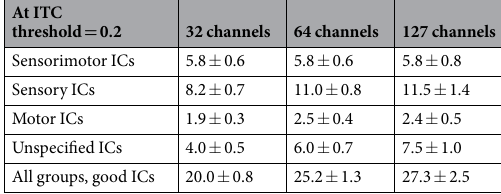
Table 1. Average number of ICs per session ( ± s.e.m.) in 32-, 64-, and 127-channel datasets and in the four groups, given the sensory and motor ITC thresholds =